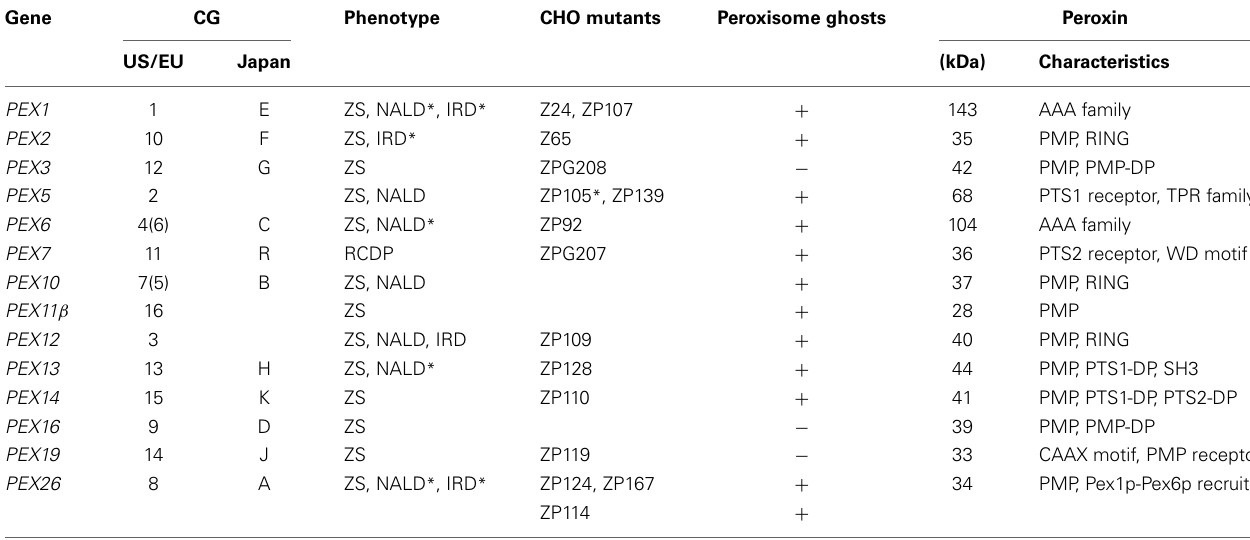
Table 1 | Complementation groups (CGs) and PEX genes of peroxisome deficiencies.